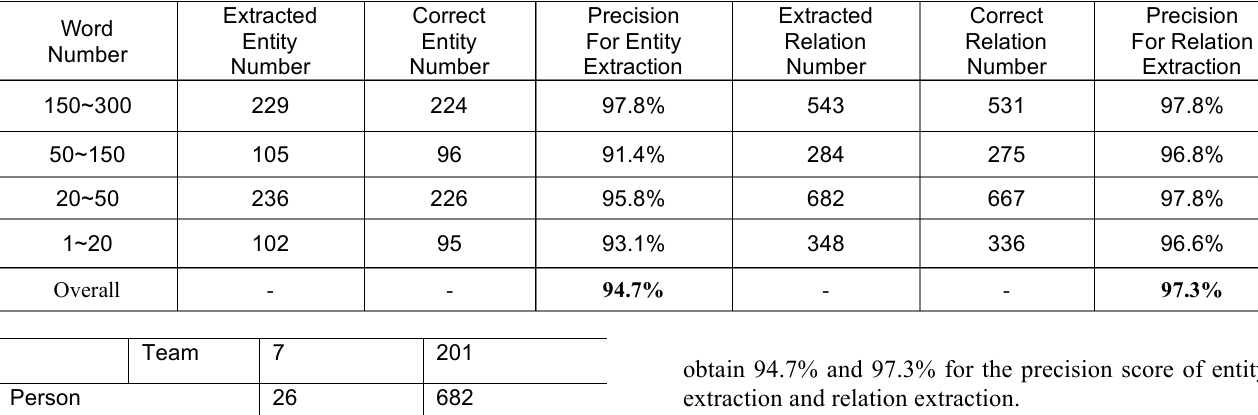
Table 10 Precision Evaluations